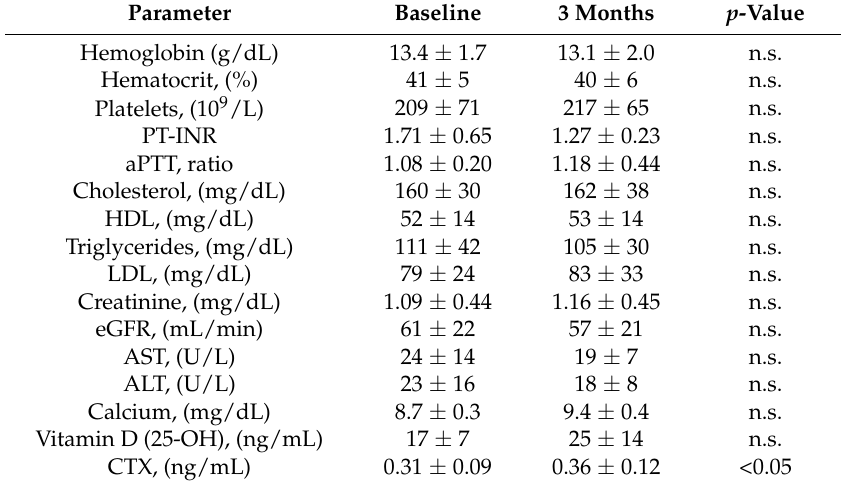
Table 2. Biochemical parameters detected before and after three months of direct oral anti-coagulant (DOAC) therapy. Continuous variables are expressed as mean ± SD; n.s (not statistically significant).